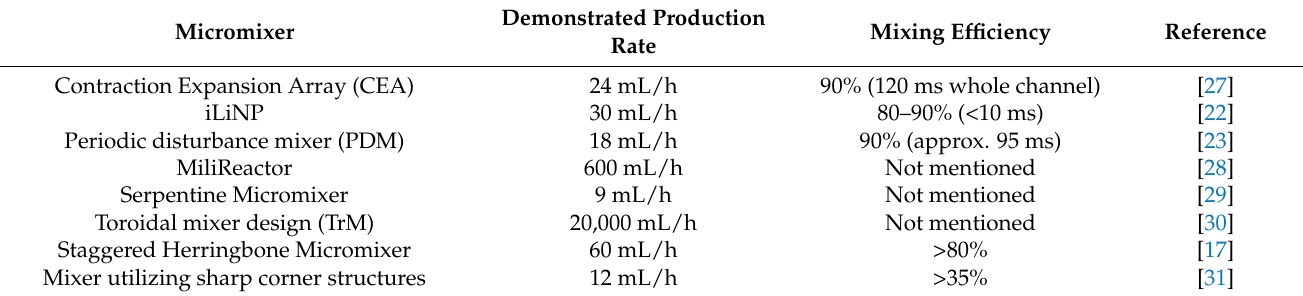
Table 1. Micromixers based on curvilinear paths used for liposome production.